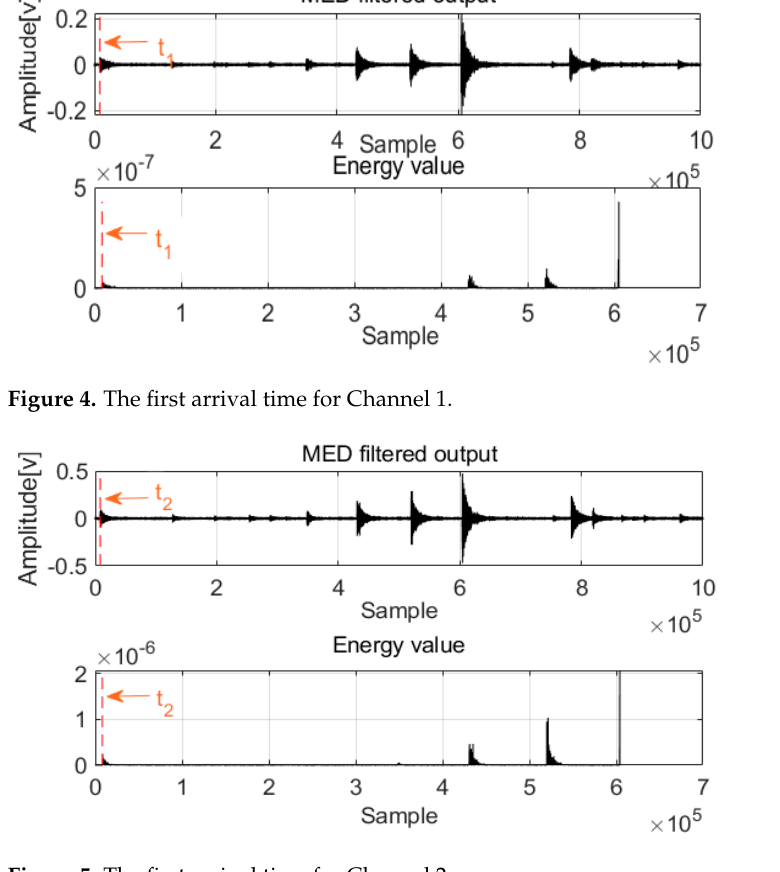
Figure 5. The first arrival time for Channel 2.